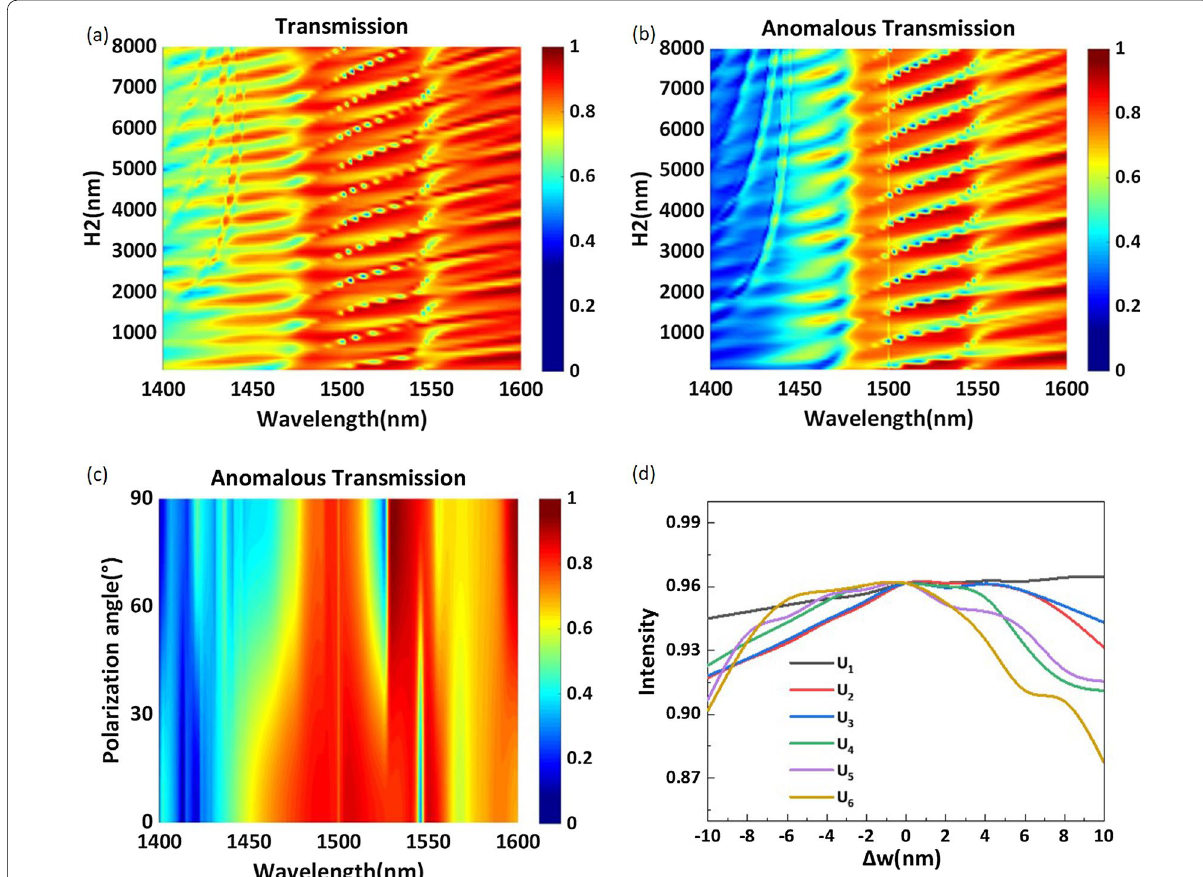
Fig. 6 a The total transmission efficiency and b the anomalous transmission efficiency as a function of the substrate thickness for the wavelength range of 1400–1600 nm. c The anomalous transmission efficiency of the proposed structure for different polarization angles in the wavelength range of 1400–1600 nm. d Calculated anomalous transmission efficiency at different values of the side length